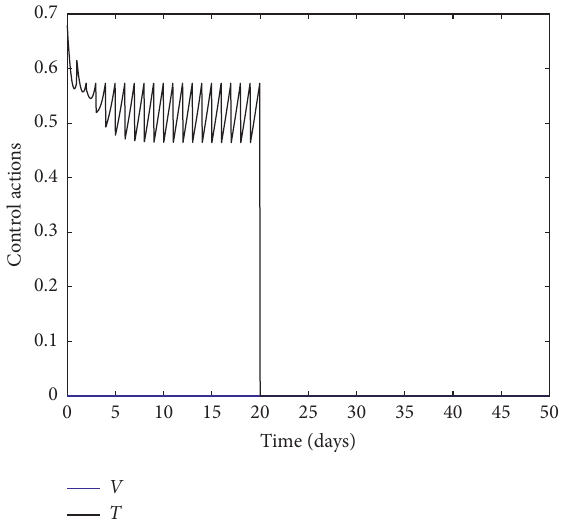
Figure 3: Vaccination and treatment efforts constrained to be nonnegative.